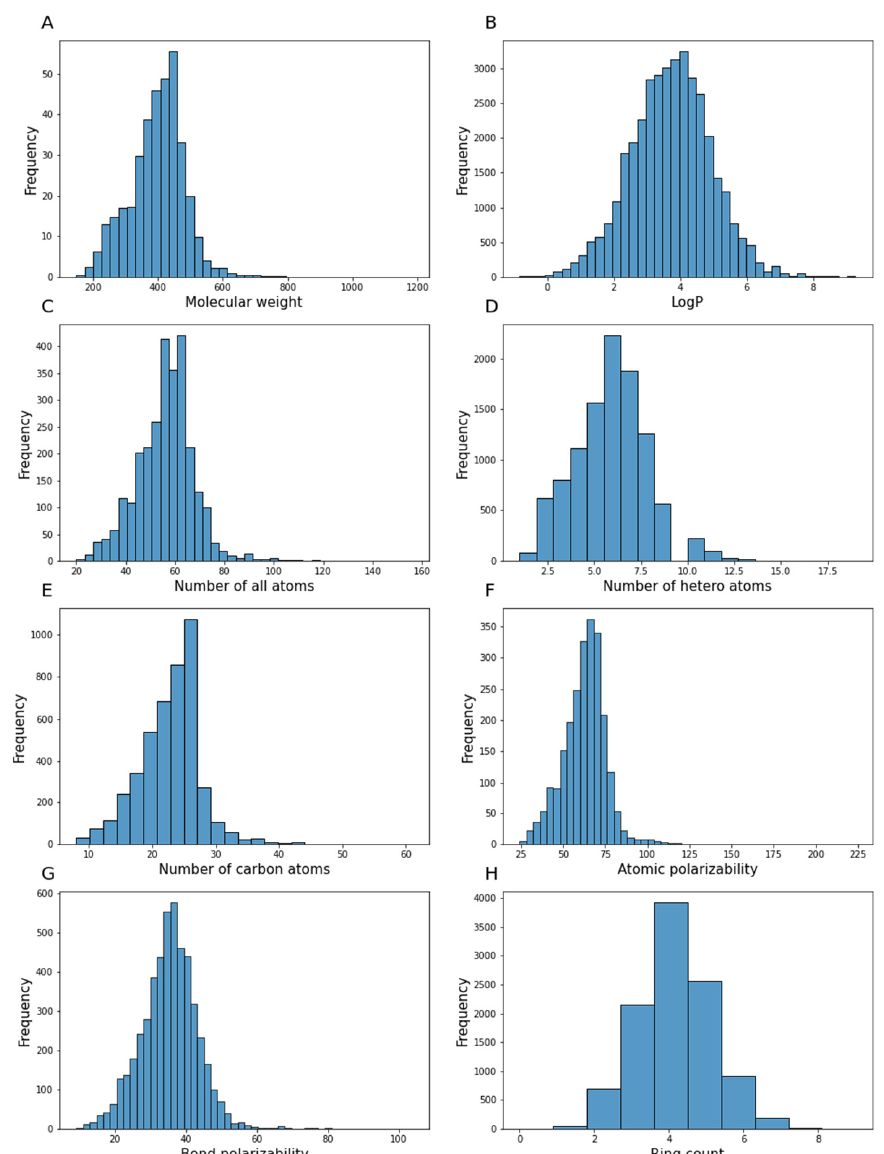
Figure 9. Example histograms of Mordred descriptor: ( A ) molecular weight, ( B ) LogP value, ( C ) number of all atoms, ( D ) number of heteroatoms, ( E ) number of carbon atoms, ( F ) atomic polarizability, ( G ) bond polarizability, and ( H ) ring count in the curated database of 5-HT1A receptors. No significant linear correlation between pKi and molecular descriptors was